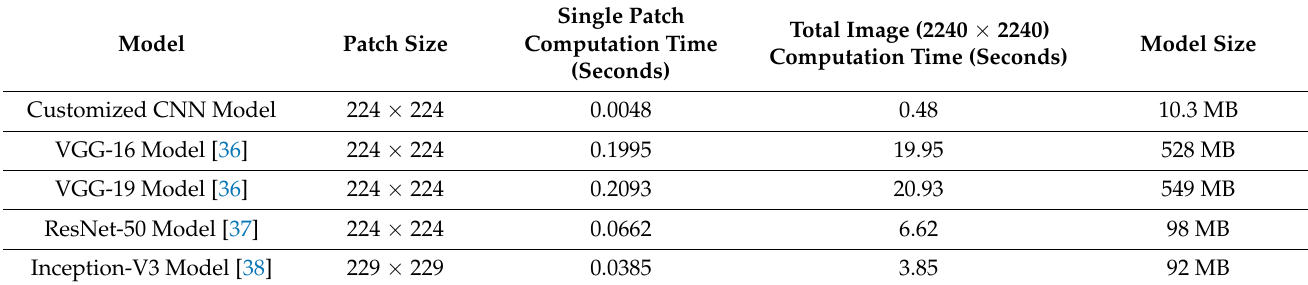
Table 5. Comparison of models computational time and